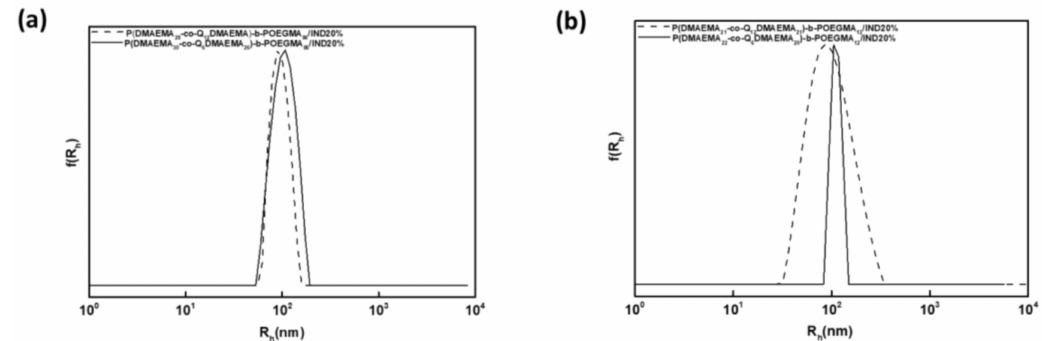
Figure 9. Size distributions from CONTIN for the mixed nanoassemblies resulting by the combination of IND at 20% and ( a ) partially quaternized PDMAEMA 56 - b -POEGMA 86 with iodohexane and iodododecane and ( b ) partially quaternized PDMAEMA 44 - b -POEGMA 12 with iodohexane and